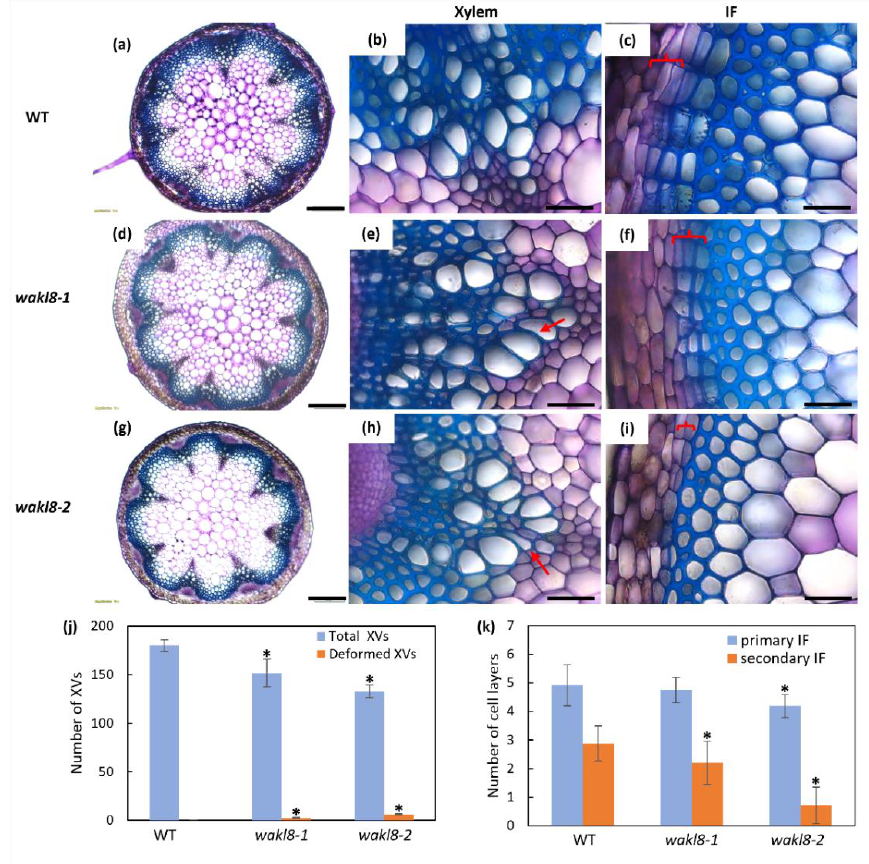
Figure 4. Histological analyses of transverse sections at 1 cm from the stem base of WT, wakl8-1 , and wakl8-2 plants. Fresh stems of WT ( a – c ), wakl8-1 ( d – f ), and wakl8-2 ( g – i ) plants at growth stage 6.5 [45] were sectioned and stained with Toluidine blue O. Thinner and slightly deformed xylem vessel (XV) walls could be observed in mutants compared with WT plants (red arrows in ( e , h )). ( j ) Quantification of the number of XVs in stem transverse sections. ( k ) Quantification of primary and secondary interfascicular fiber (IF; red brackets) layers in stem transverse sections. Scale bar = 200 µ m in ( a , d , g ), 20 µ m in ( b , c , e , f , h , j ). Data shown as average ± SD acquired from three biological replicates. * Significant difference compared with WT plants, p < 0.05 using Student’s t